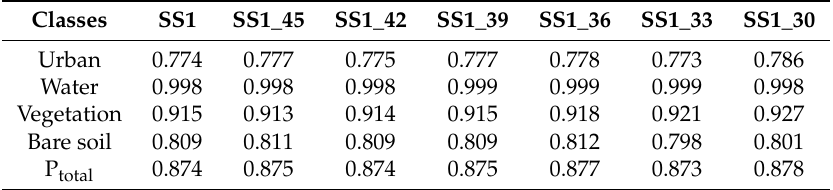
Table 23. Probabilities of correct classification depending on compressed image quality for Set 1, AGU coder, NN classifier.